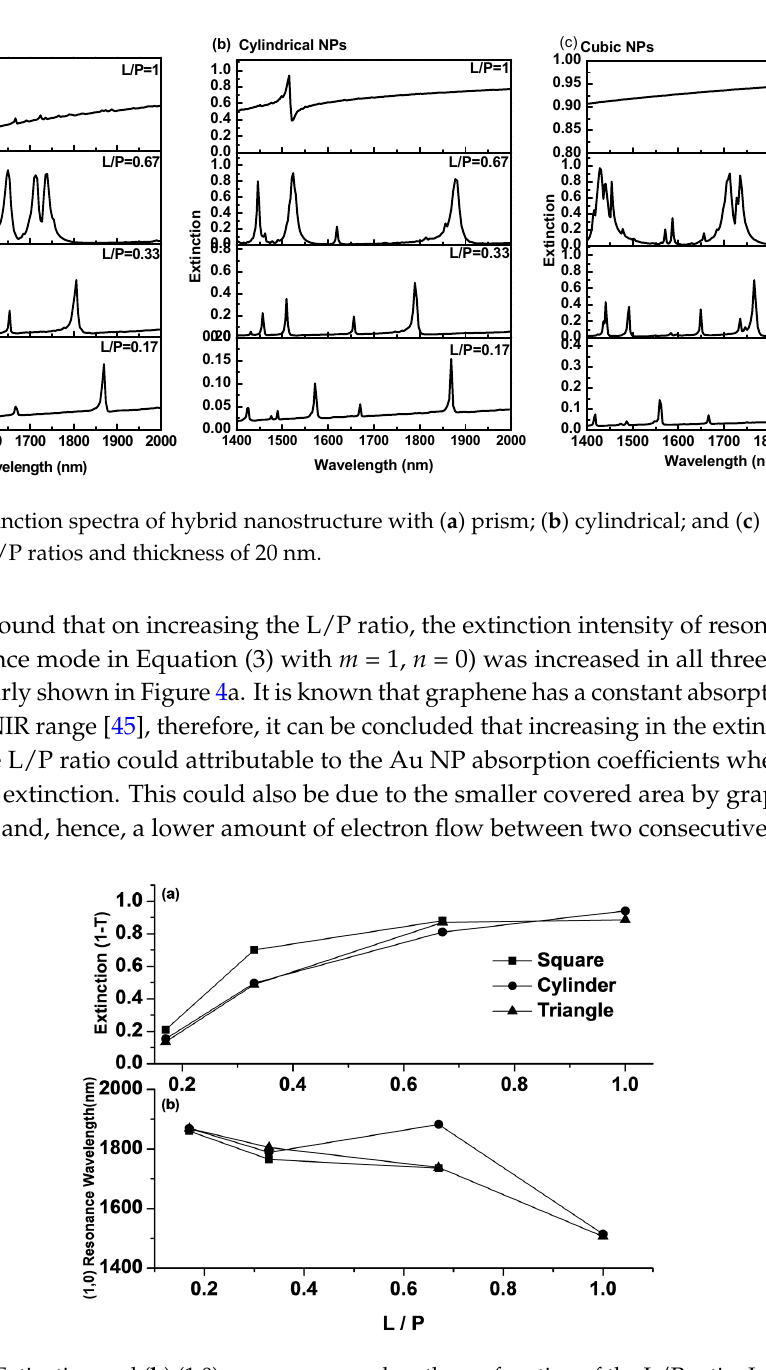
Figure 4. ( a ) Extinction and ( b ) (1,0) resonance wavelength as a function of the L/P ratio. L is the side length and P is the separation distance between two consecutive NPs.